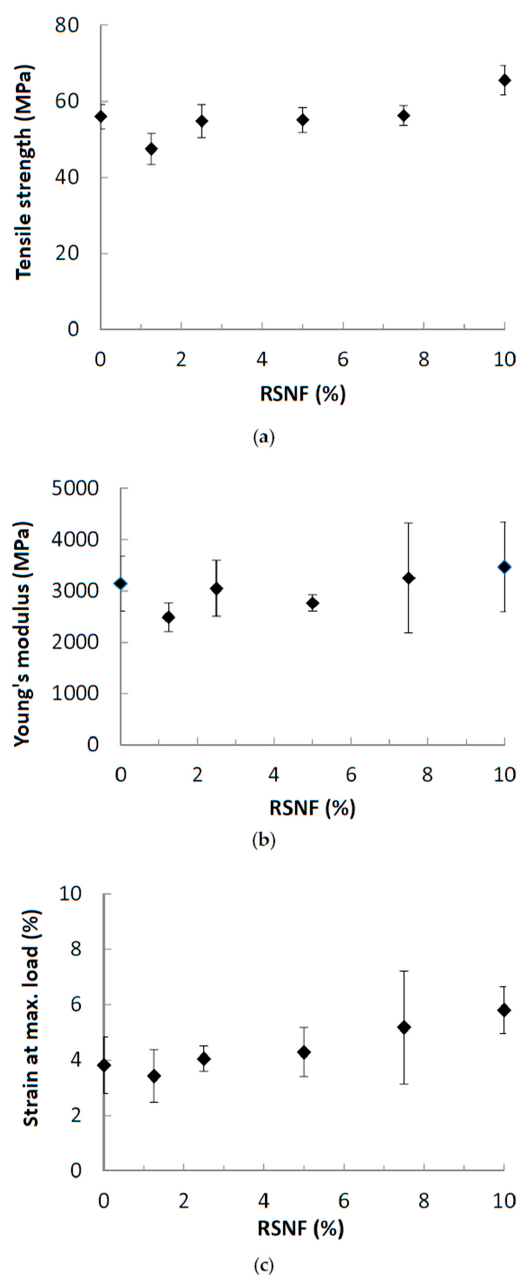
Figure 8. Tensile strength properties of CA films containing different ratios of RSNF contents. ( a ) tensile strength, ( b ) E-modulus, and ( c ) strain to failure.